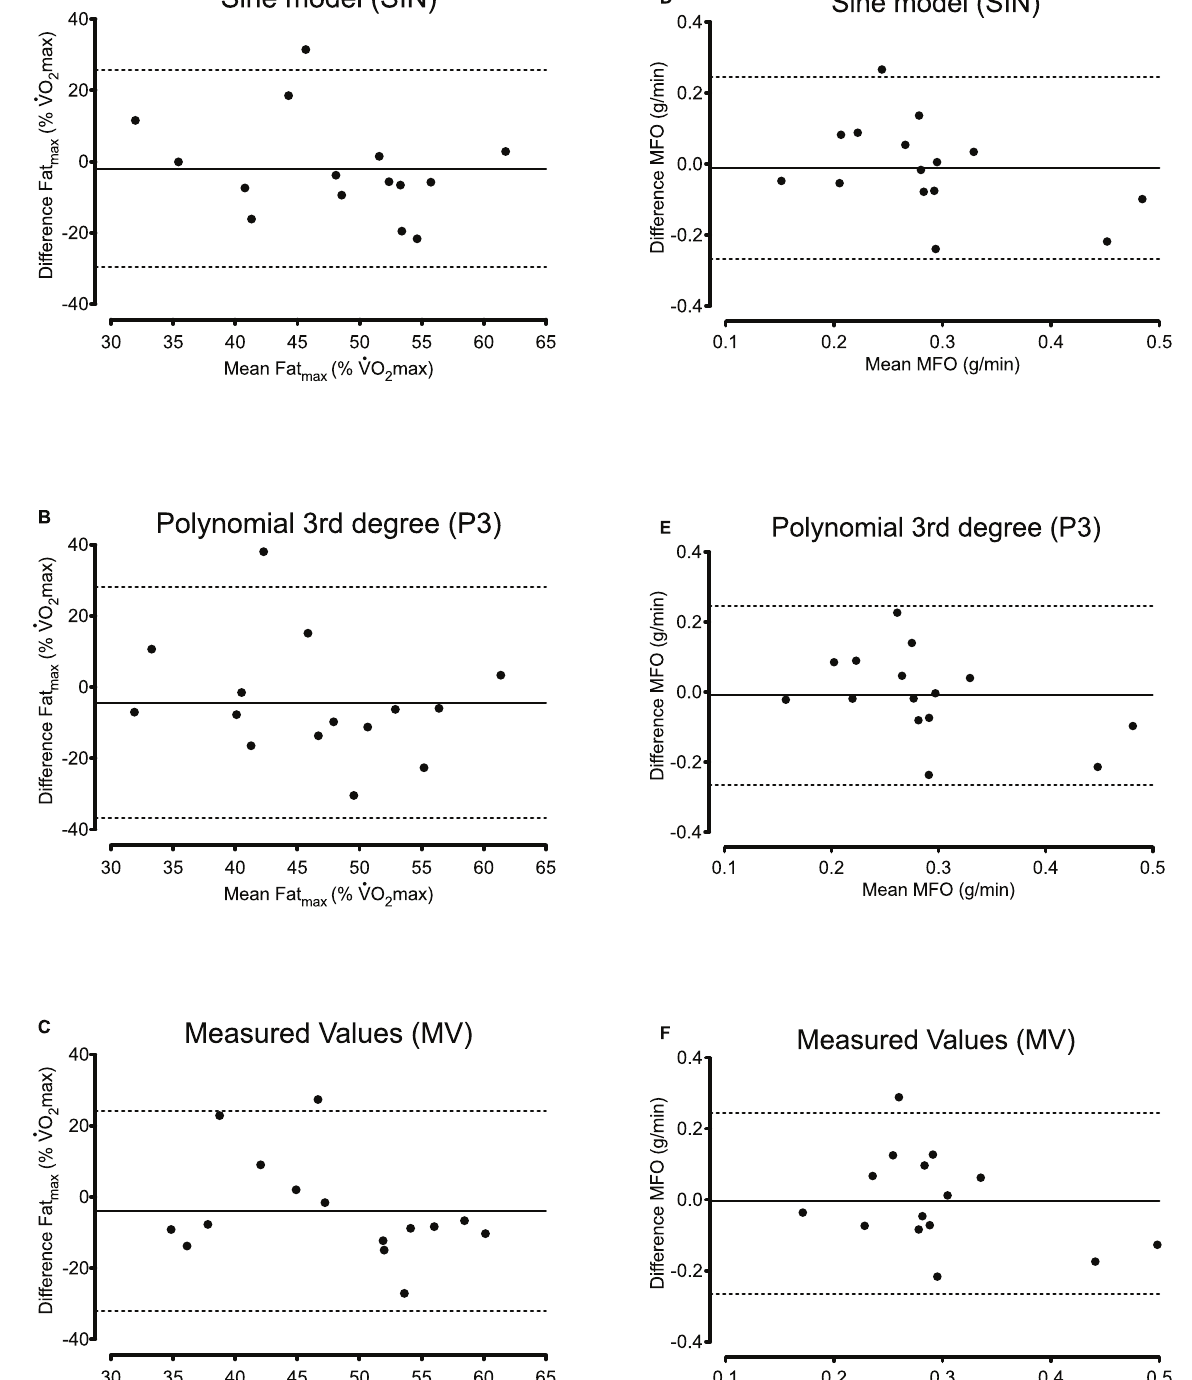
Figure 1. Bland-Altman plots of Fat max and MFO determined with SIN, P3 or MV. SIN, sine model. P3, polynomial 3 rd degree; MV, measured values; Fat max , exercise intensity at which maximal fat oxidation rate occurs; _ VVO 2max , maximal oxygen uptake; MFO, maximal fat oxidation rate; Biases ( solid lines ) and 95% limits agreement ( dashed lines ).